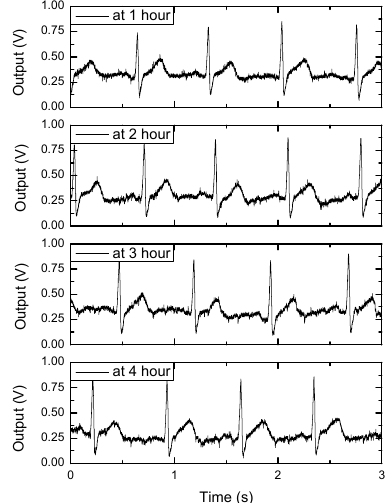
Figure 11. Measured electrocardiogram (ECG) signal in electropotential (EP) mode.